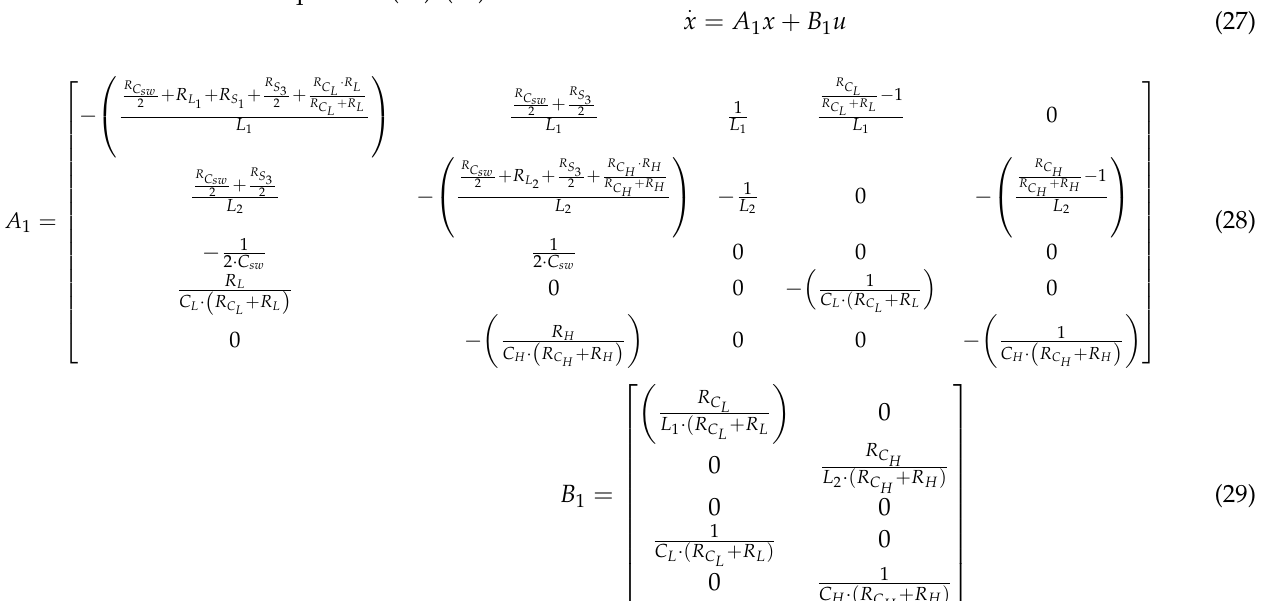
The state-space representation for t on and the corresponding matrices are given in Equations (27)–(29).